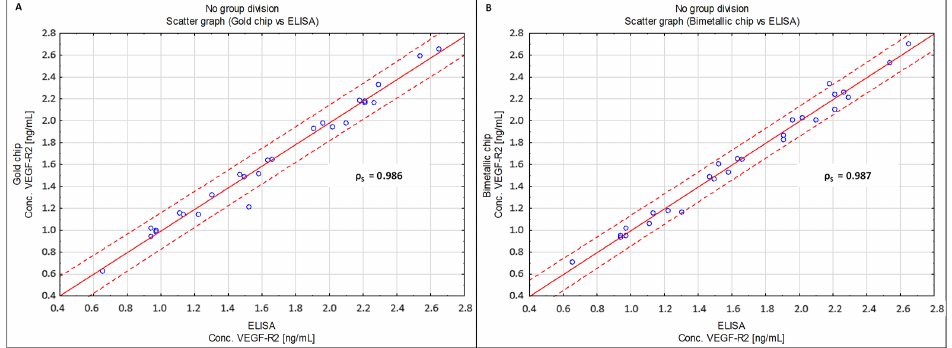
Figure 9. Scatterplot comparing the developed methods with ELISA and showing Spearman’s rank correlation coefficient ρ S. ( A ) gold chip vs. ELISA; ( B ) bimetallic chip vs. ELISA.